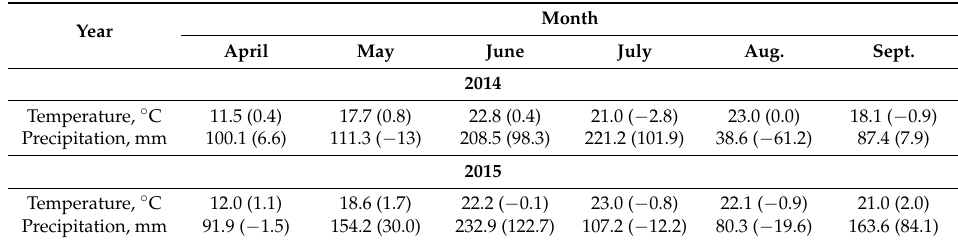
Table 1. Monthly weather data for Champaign, IL, USA during the production seasons of 2014 and 2015. Temperature is the average daily air temperature and precipitation is the average monthly accumulated rainfall. Values were obtained from the U.S. National Oceanic and Atmospheric Administration and values in parentheses are the deviations from the 30-year average (1981–2010).